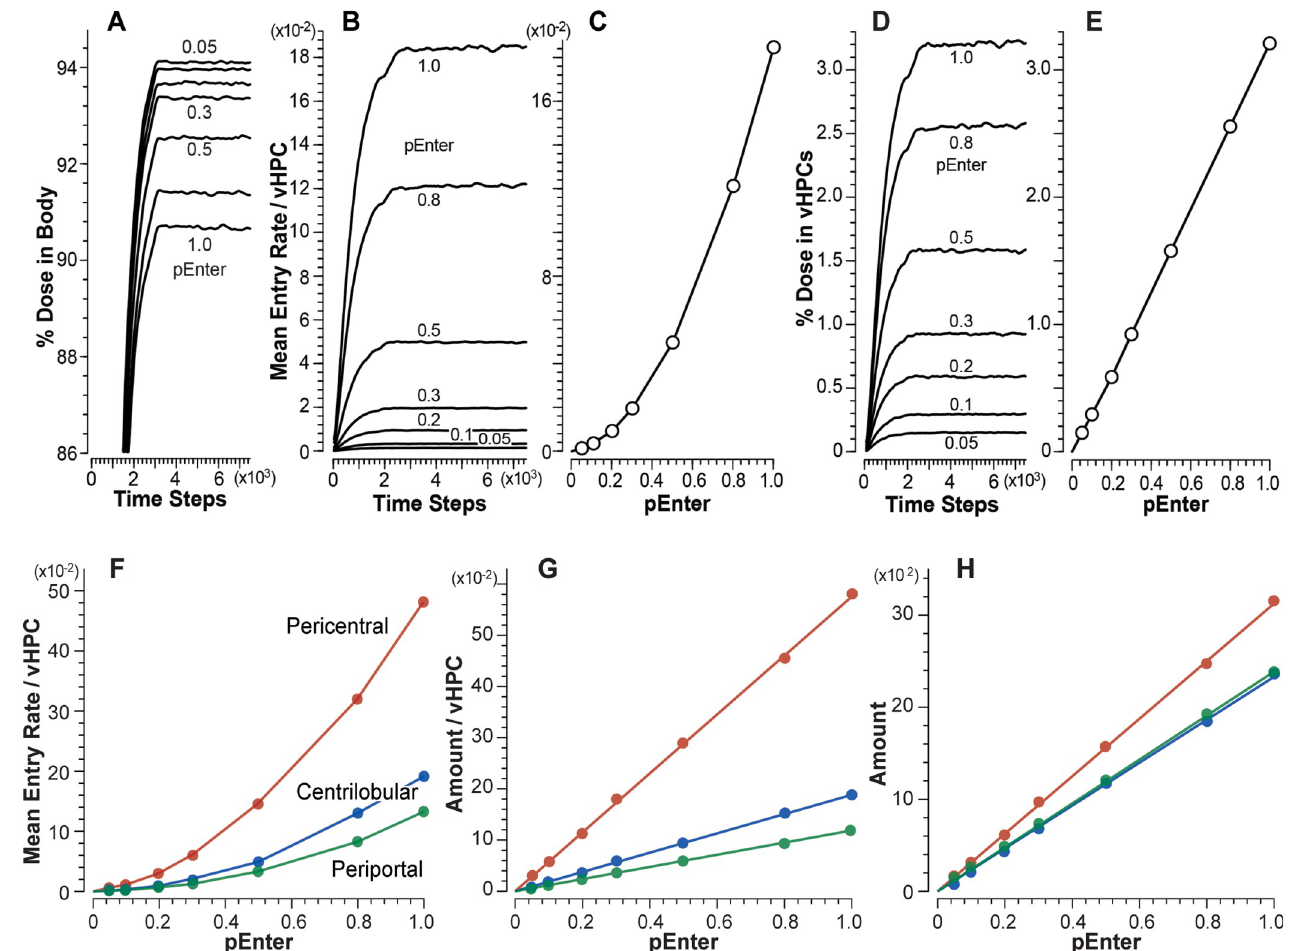
Fig 5. Results from vHuman experiments using vC1. (A) Temporal measures of percent Dose in Body for each pEnter . (B) Temporal measures of mean Entry rates for each pEnter . (C) Correlation between mean dynamic steady-state Entry rates and pEnter . (D) Temporal measures of percent Dose in vHPCs for each pEnter . (E) Correlation between mean dynamic steady-state amounts of vC1 in vHPCs and pEnter . Measures in F-H are mean dynamic steady-state values within the Periportal, Centrilobular, and Pericentral bands in Fig 3B. (F) Correlation between mean dynamic steady-state Entry rates and pEnter . (G) Correlation between vC1 amounts per vHPC and (H) total amounts within all vHPC and pEnter .